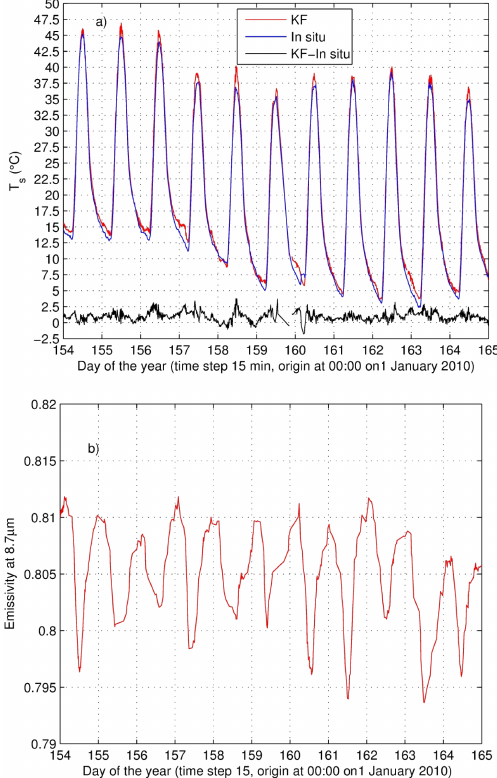
Figure 13. Gobabeb station surface temperature (a) and 8.7µm emissivity (b) retrieval for a clear-sky sequence of days in June 2010. The emissivity retrieval has been smoothed with a moving- average filter with a time window of